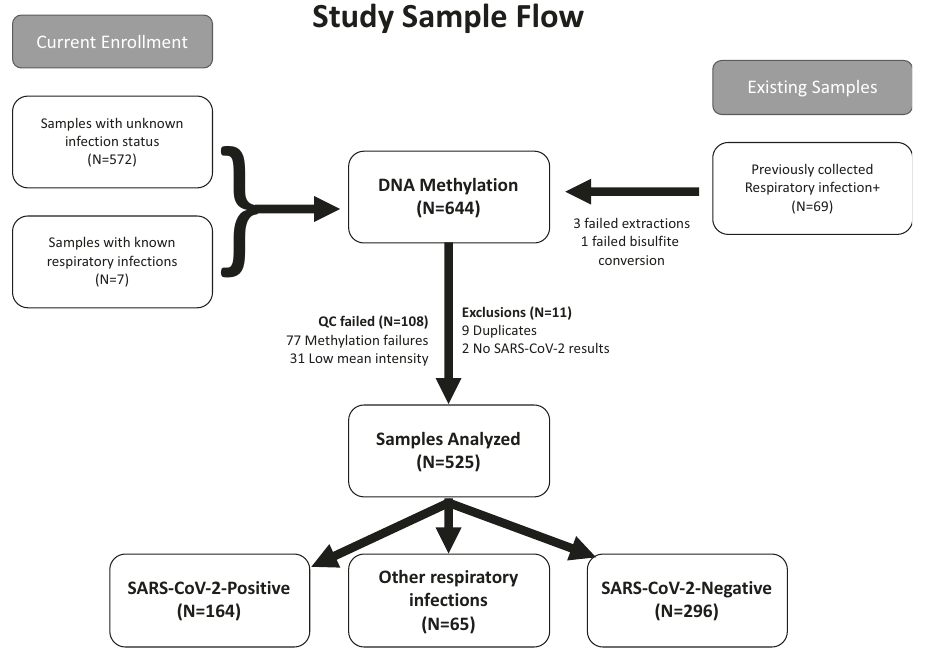
Fig. 1 Flowchart of the study sample collection. Six hundred and forty-eight samples were collected for analysis, of which 644 were processed on MethylationEPIC arrays. Five hundred and twenty- fi ve arrays passed quality control and were included in the fi nal